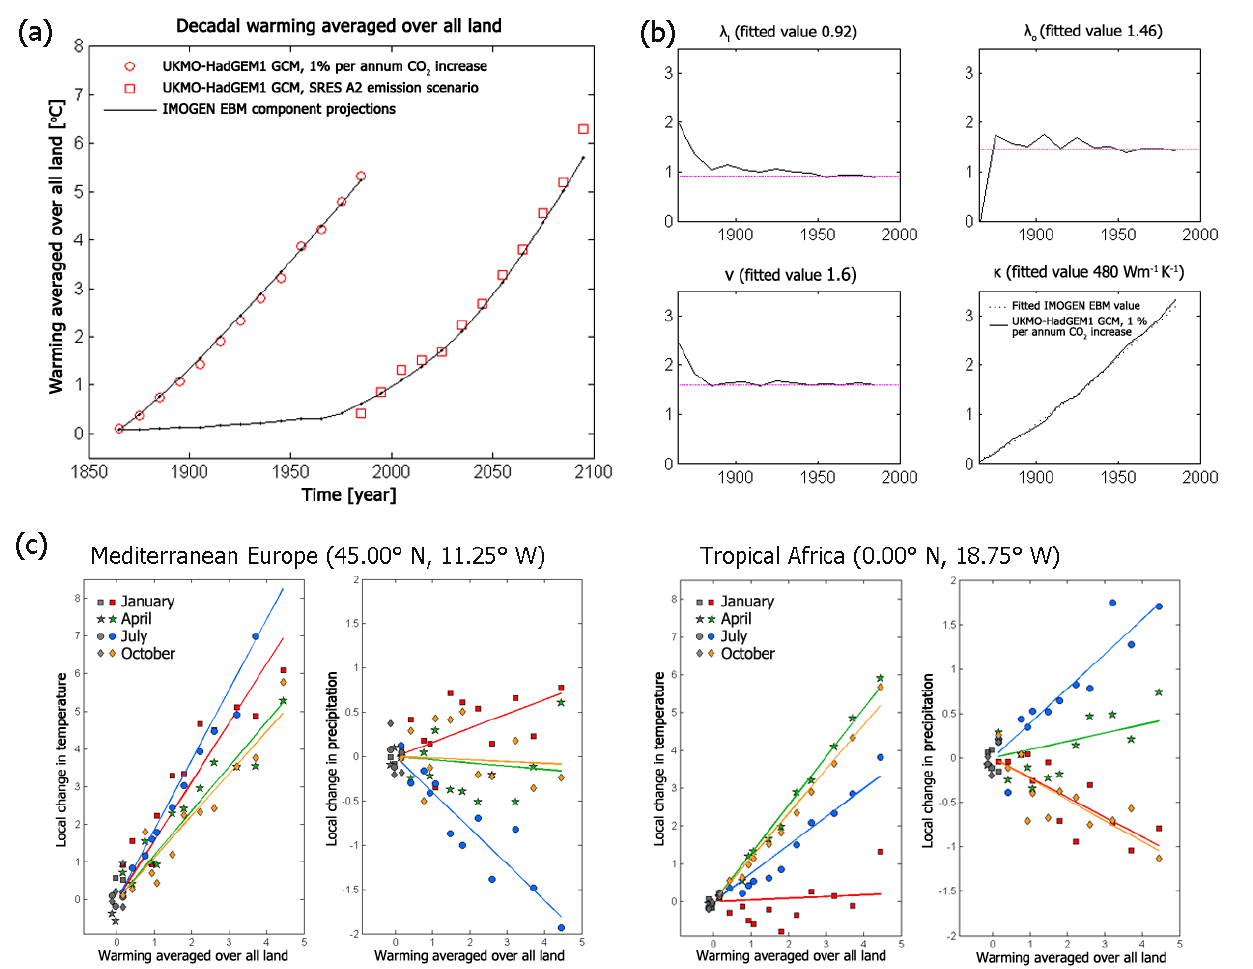
Figure 1. Illustration of the process leading to parameterization of the IMOGEN energy-balance model and the scaled climate patterns (together forming the “pattern-scaling set”), based on the example of the UKMO-HadGEM1 GCM. (a) Emulation of a warming pathway across time. The 1% to quadrupling atmospheric CO 2 run was used for calibration of the energy-balance model while the SRES A2 scenario run was used to validate the results. (b) Fitting of the individual EBM parameters, underlining the match presented in (a) . Climate sensitivities over land λ l and ocean λ o , as well as the ratio of land to ocean warming rate, ν (pink lines), are derived directly from GCM run data (black curves, 1% run). The fourth parameter, an ocean effective thermal diffusivity, κ , determines modelled oceanic temperature profile. The κ value is selected based upon comparing calculated values of top-of-profile temperature against global mean SST changes projected by UKMO-HadGEM1 1% run (shown). (c) Example local fitting of patterns of temperature and precipitation, found as regression coefficients (coloured straight lines) against calculated changes in mean temperature over land from UKMO-HadGEM1. Two representative grid boxes in Mediterranean Europe and tropical Africa are shown. Coloured symbols are decadal mean monthly values from the UKMO-HadGEM1 SRES A2 run, whilst the grey markers represent data from the 20C3M simulation, which were used to normalise to temperature and precipitation change, and are also corresponding to CRU normals (years 1961–1990). Regression pattern fit is forced through [0,0] point, as in